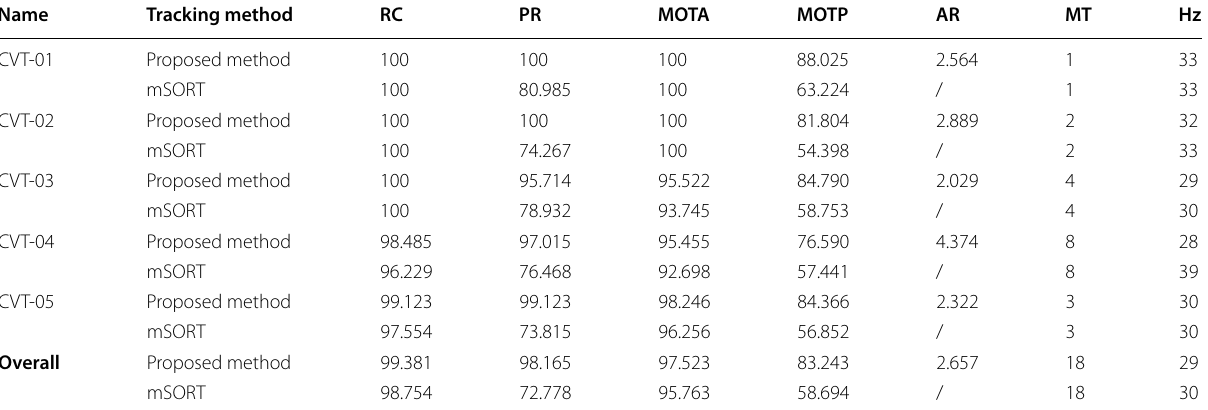
Table 2 Quantitative evaluation tracking results for the evaluation